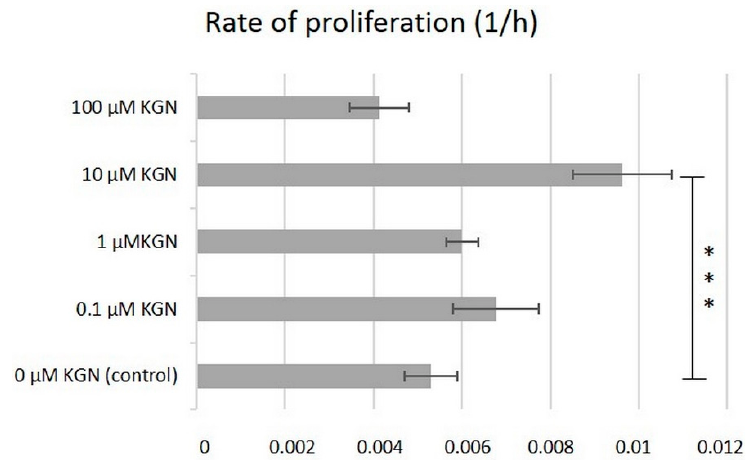
Figure 1. Effect of KGN on therate of proliferation of hBMSCs in monolayer culture during nine days. Values are expressed as mean ± SD ( n = 4). *** p < 0.001 vs. the control group (hBMSCs in culture medium).